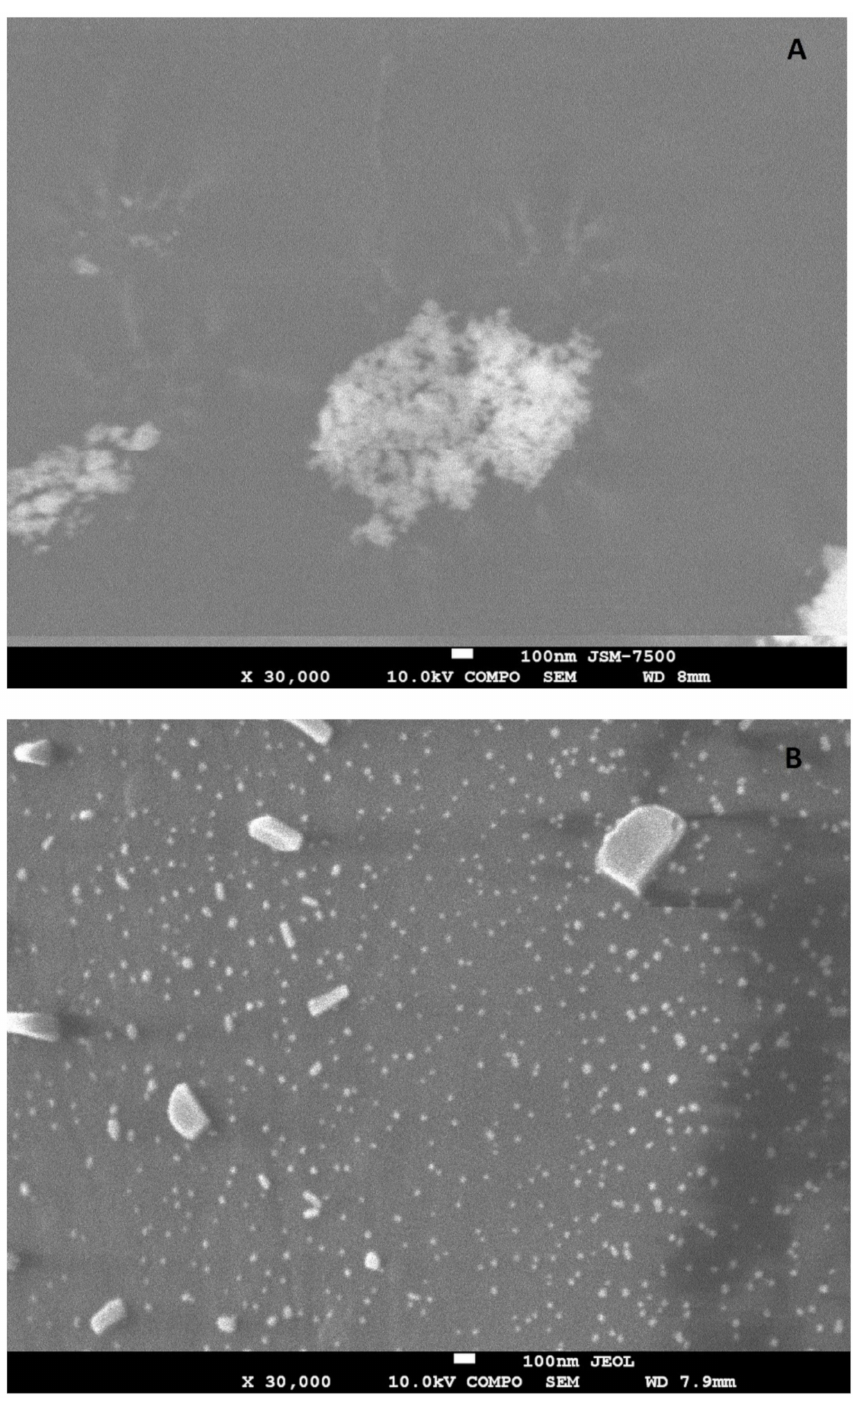
Figure 4. SEM photographs of silver nanoparticles on the surface of the catgut suture material: ( A ) before cyclic freezing/thawing; ( B ) after 10-fold cyclic freezing/thawing. Despite an increase in the total number of nanoparticles of all sizes after cyclic freezing by more than 9.9 times ( p < 0.05), no significant differences were found in the ratio of silver nanoparticles with sizes from 31 to 40 nm ( p > 0.065), 41 nm and more ( p > 0.336). This result indicates an increase in the number of AgNPs after the cyclic freezing process on catgut exclusively for nanoparticles of small and medium diameters (i.e., no more than 30 nm, Figure